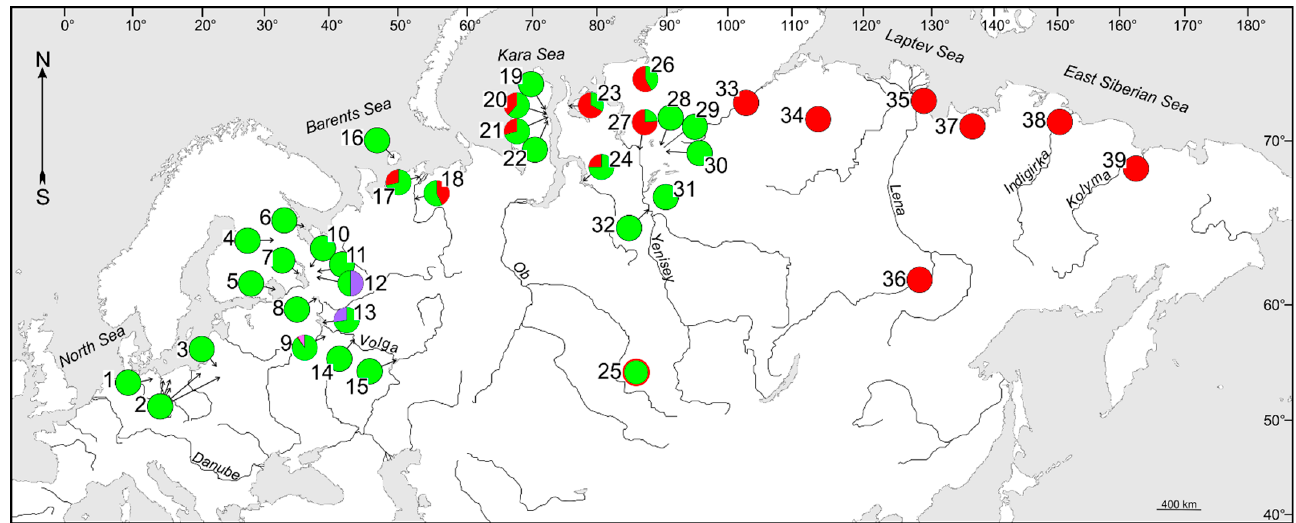
Figure 1. The distribution of phylogenetic mitochondrial lineages of considered cisco species over waterbodies of Arctic Eurasia: red circles—lineage IC, green—IIC, light purple—IIIC, pink—IVC. Location of populations: 1–Lake Stechlin ( C. albula and C. fontanae ); 2–lakes of Poland: Byty ń , P ł ociowe, Drawsko, Marta, Miedwie, Morzycko, Wigry, Ostrowieckie, Ż erdno, and Narie; 3–Lake Vištytis, Kaliningrad Region; 4–Lake Khedo; 5–Lake Ladoga; 6–lakes of the Solovetsky Archipelago: Bol’shoye Krasnoye, Gremyacheye, and Bol’shoye Ostrech’ye; 7–Lake Onega; 8–Lake Beloye; 9–Lake Pleshcheyevo; 10–Lake Vodlozero; 11–Lake Kenozero; 12–Lake Lyokshmozero; 13–Rybinsk Reservoir; 14–Gorky Reservoir; 15–Kuybyshev Reservoir; 16–waterbodies of the Kolguyev Island; 17–Pechora River, Lake Golodnaya Guba, saurey; 18–Pechora River, watercourse and estuary, zeld; 19–Nyakharvangata- Yakha River; 20–Sabetta-Yakha River; 21–Venujmue-Yakha River; 22–Lake Yoserotato; 23–Nyojta- Yakha River; 24–Messo-Yakha River; 25–Lake Ingol (introduced population of C. albula ,